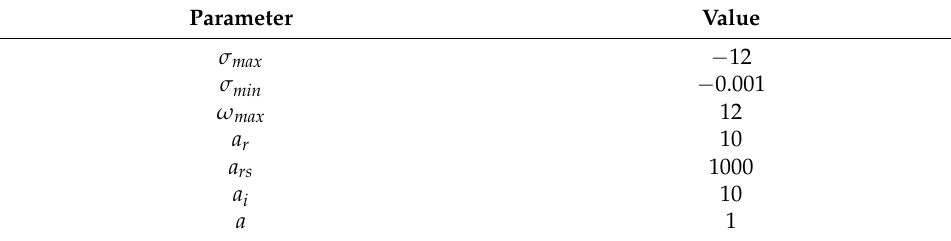
Table A4. Parameters of the fitness